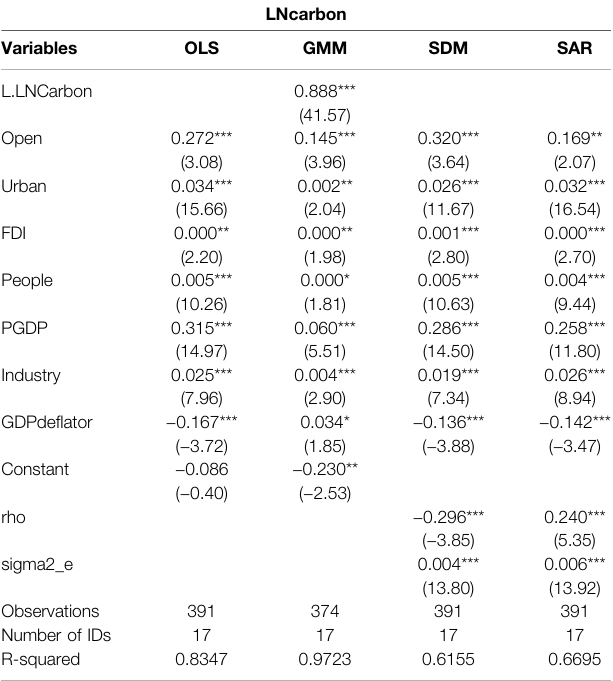
TABLE 8 | Results of the robustness